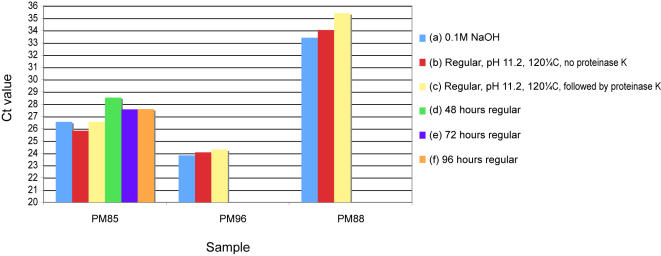
The relative PCR-amplifiable nuDNA yields resulting from different extraction techniques (a–f) on 3 different formalin fixed samples.Only sample PM85 was extracted with techniques (d–f). Techniques (a–c) are based on the hot-alkali methods of Shi et al. [22], [23], while techniques (d–f) are conventional proteinase k digestion techniques with extended digestion times. Note that in conventional quantitative real-time PCR assays, the measure of PCR amplifiable DNA (the Ct value) is inversely related to the starting concentration of DNA. Therefore, lower Ct values indicate higher original PCR amplifiable DNA yields. Although too small a sample to provide statistically supported findings, the data suggest that while there is little difference between the efficacies of the different hot alkali techniques themselves, they provide marginally higher levels of PCR amplifiable nuDNA.